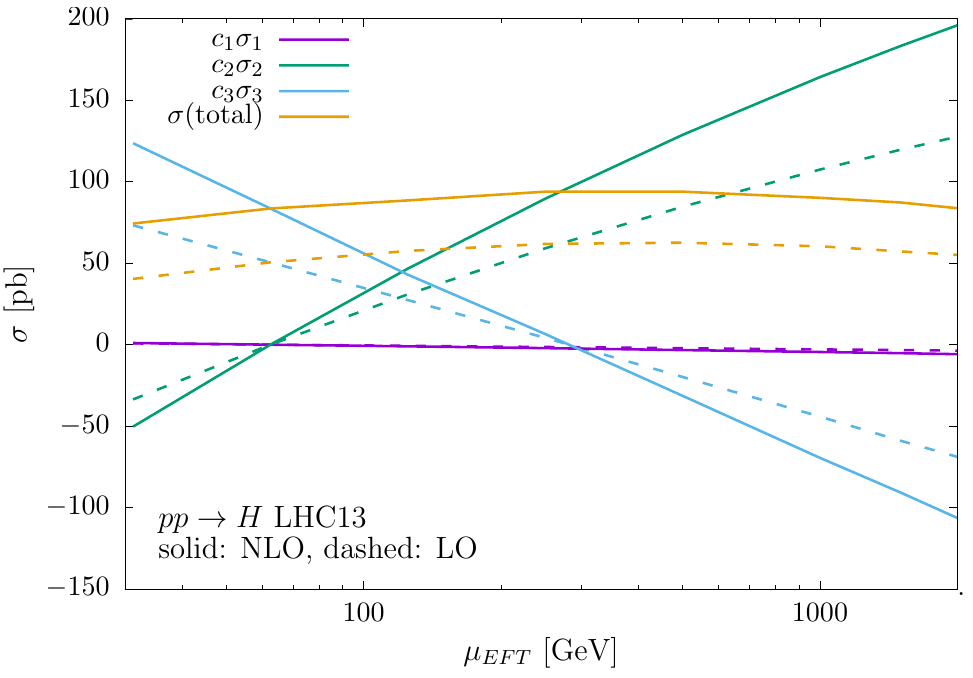
Figure 7 . Contributions of the three operators to the inclusive Higgs production cross section at the LHC at 13 TeV as a function of the EFT scale. Starting from one non-zero coe(cid:14)cient at (cid:22) EFT = m H = 2 we compute the EFT contributions at di(cid:11)erent scales, taking into account the running and mixing of the operators. LO and NLO predictions are shown in dashed and solid lines